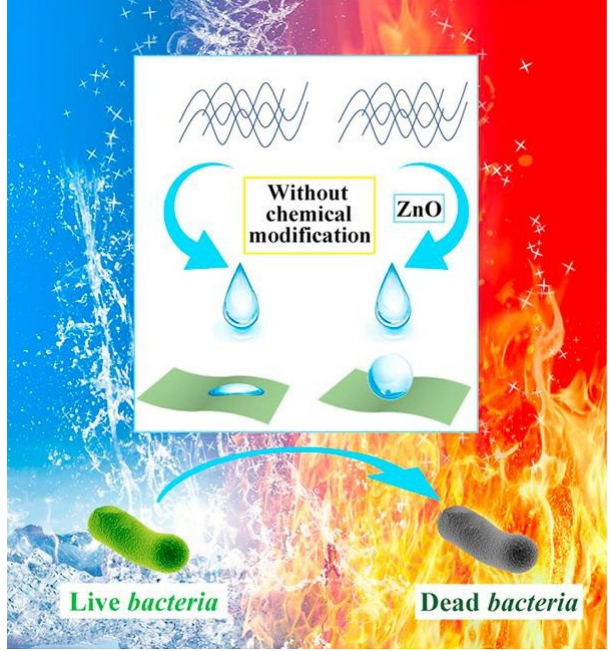
Figure 3. Bactericidal effect of modifier-free superhydrophobic and flame-resistant paper. Repro- duced with permission from [10]. Copyright 2018 Elsevier.